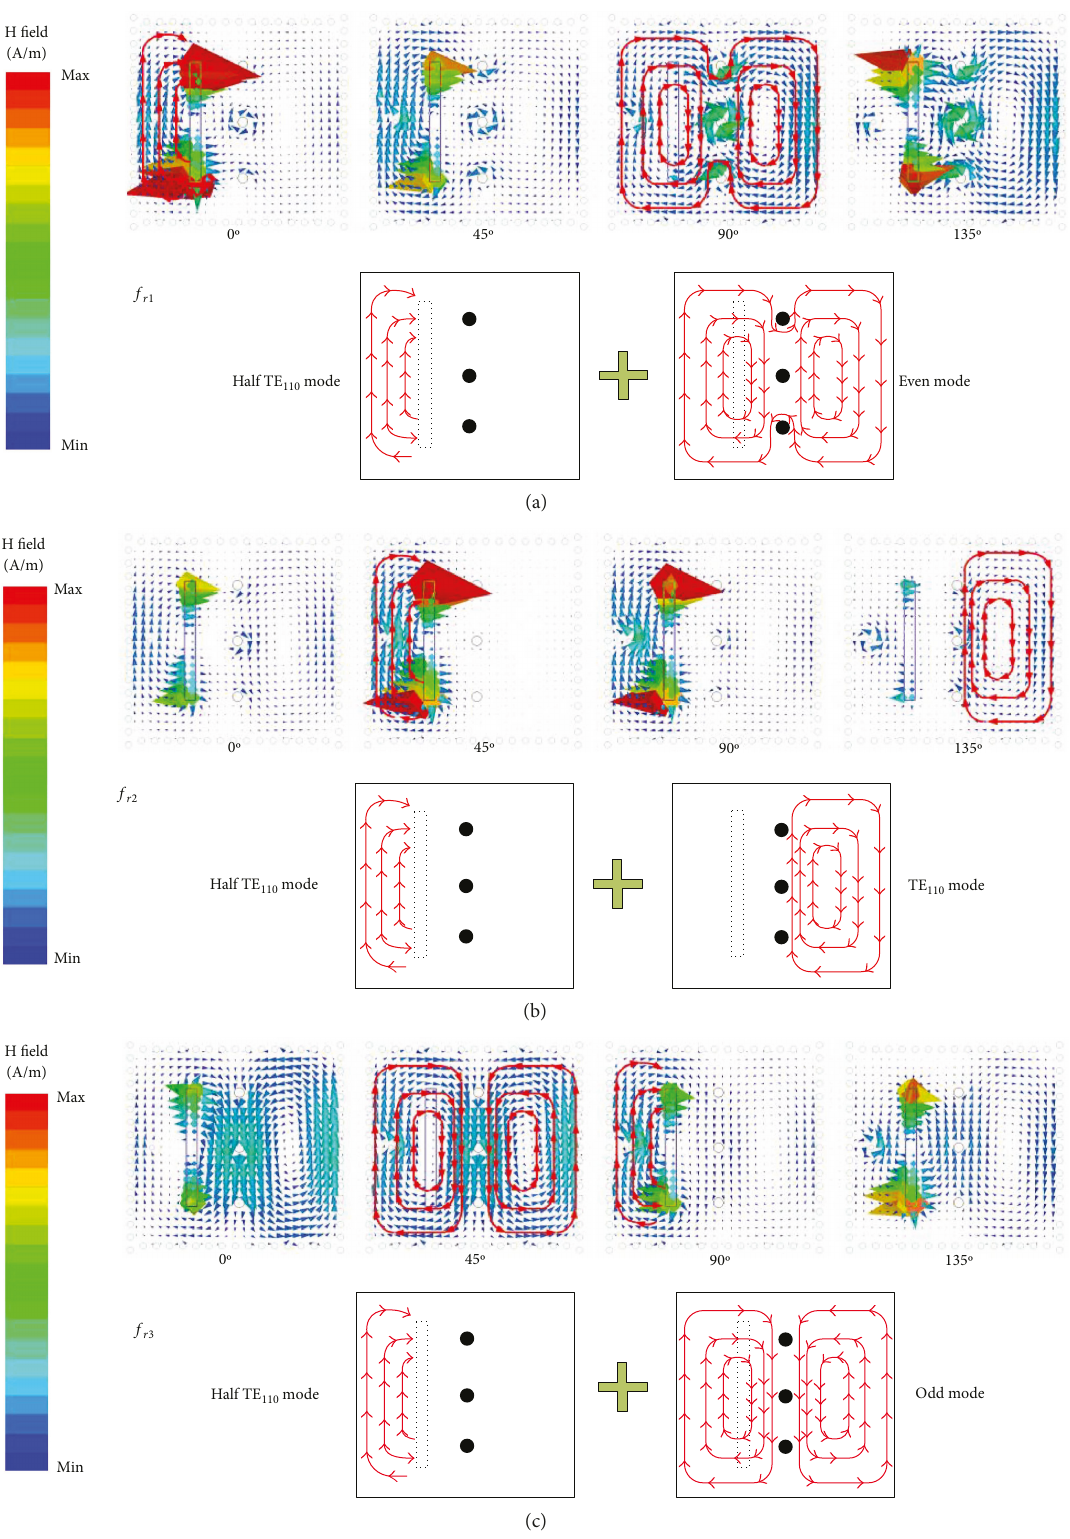
Figure 9: Illustration of the mechanism of resonance poles in Ant. 3. (a) First resonance pole f resonance pole f r 3